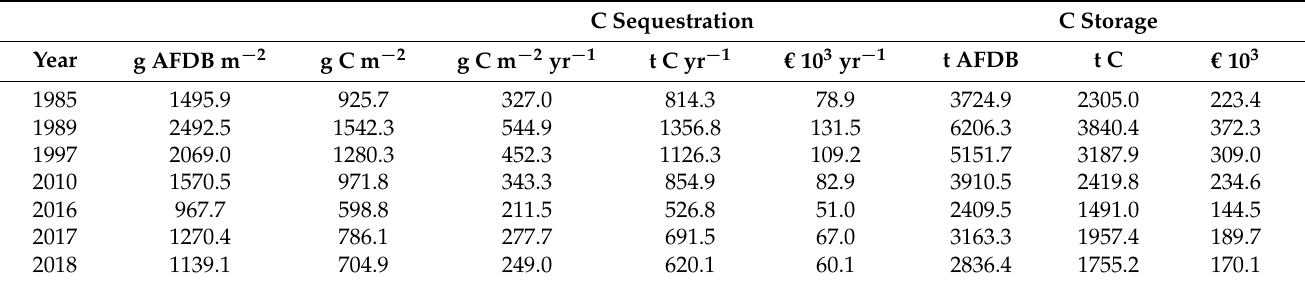
Table 4. Carbon sequestration and storage provided by Valle Santa wetland and related monetary values over time. C Sequestration C Storage